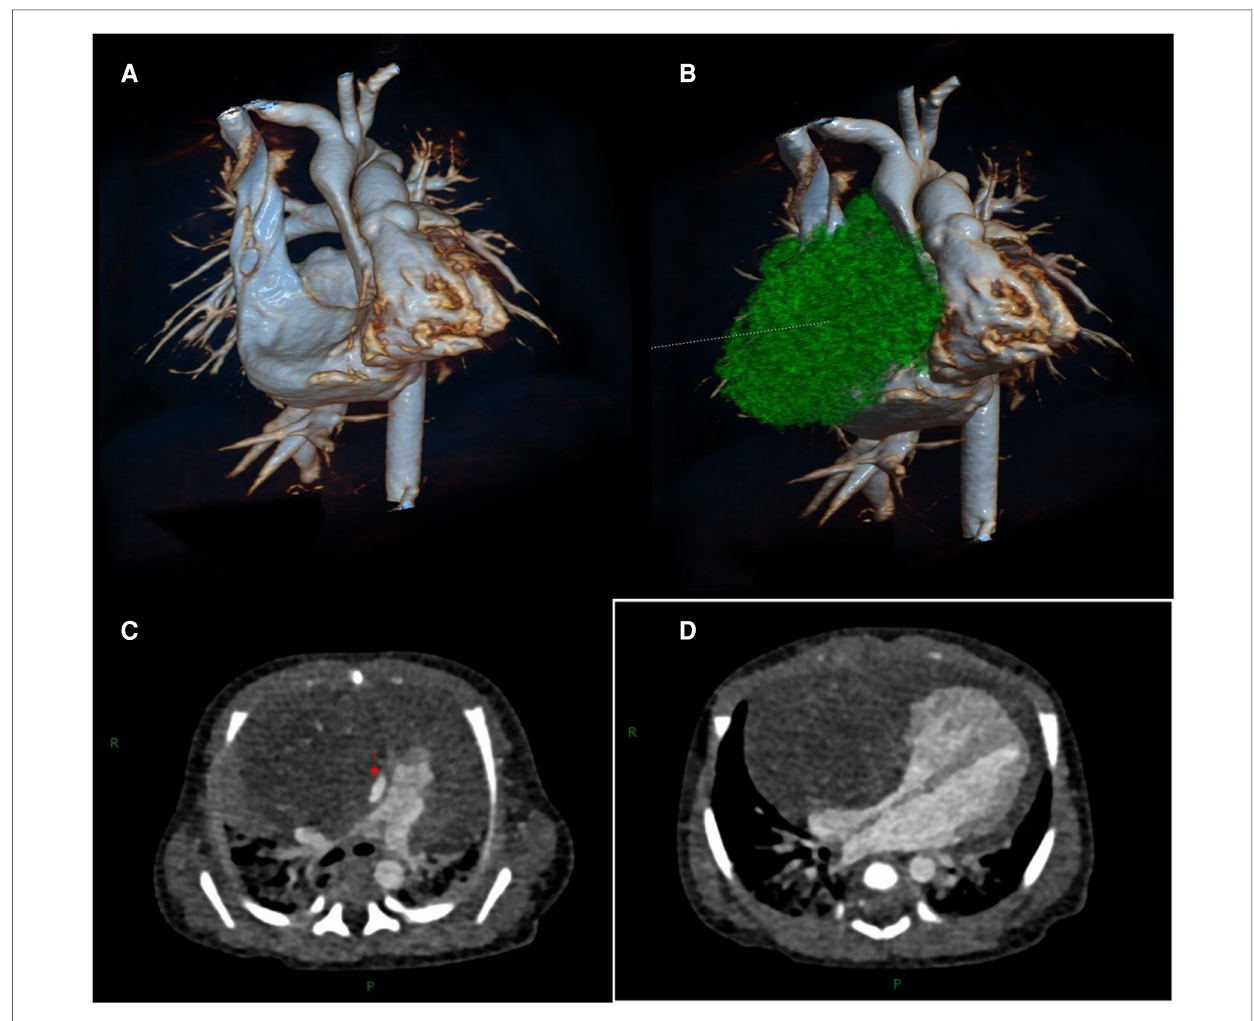
FIGURE 3 Cardiac computed tomography angiography images. ( A, B ) Three-dimensional modeling images show a huge mass in the right front of the heart, which severely compresses the ascending aorta and right atrium. ( C ) The aorta (red arrow) is compressed and fl attened by the mass. ( D ) The mass compresses the right